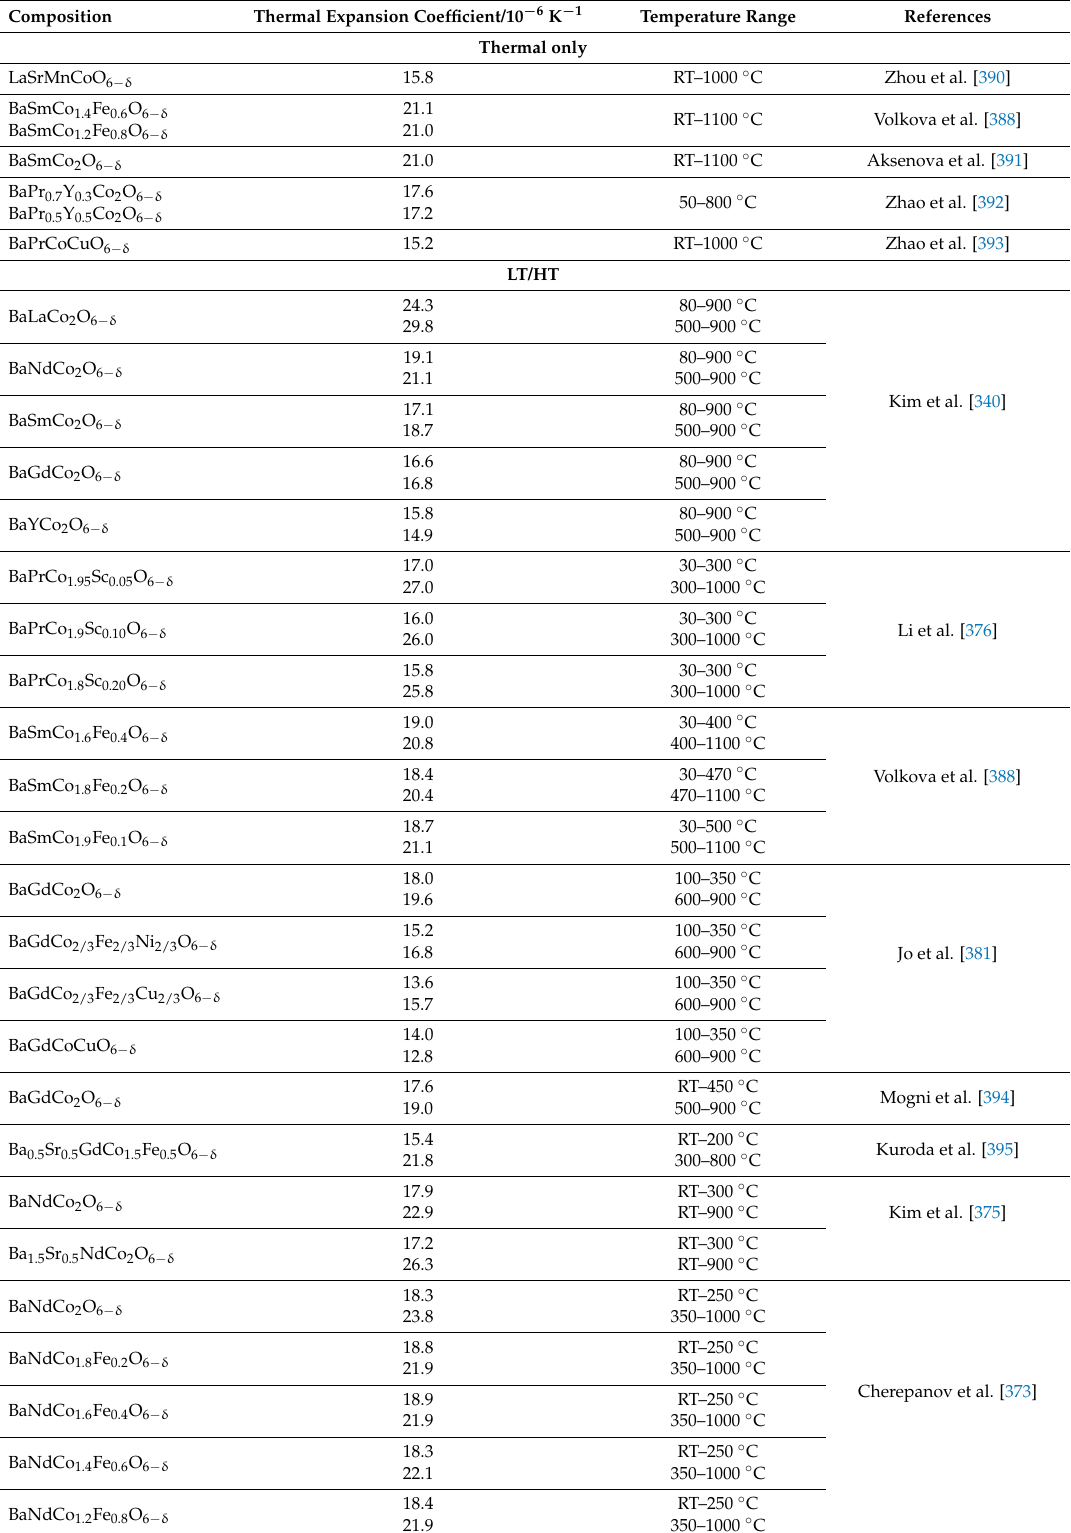
Table 12. Linear thermal expansion coefficients of BaRECo 2 − x M x O 6 − δ and some related double perovskites. The data are separated in different categories: no chemical expansion reported (thermal only, linear over the entire temperature range), separation in different temperature ranges (low temperature LT and high temperature HT) and average over a large temperature